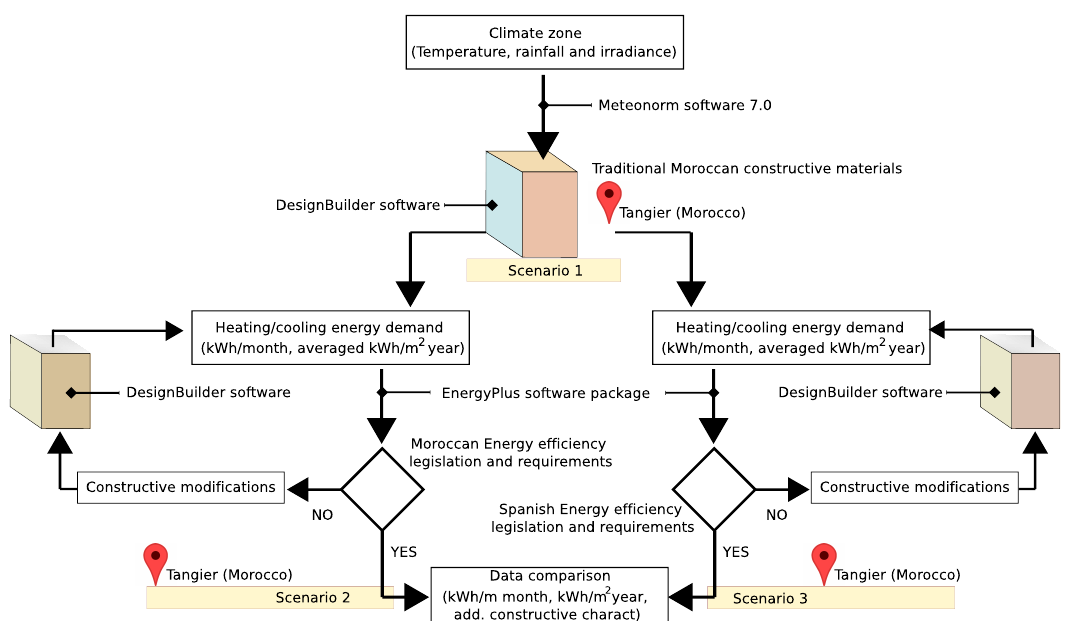
Figure 5. Methodology general